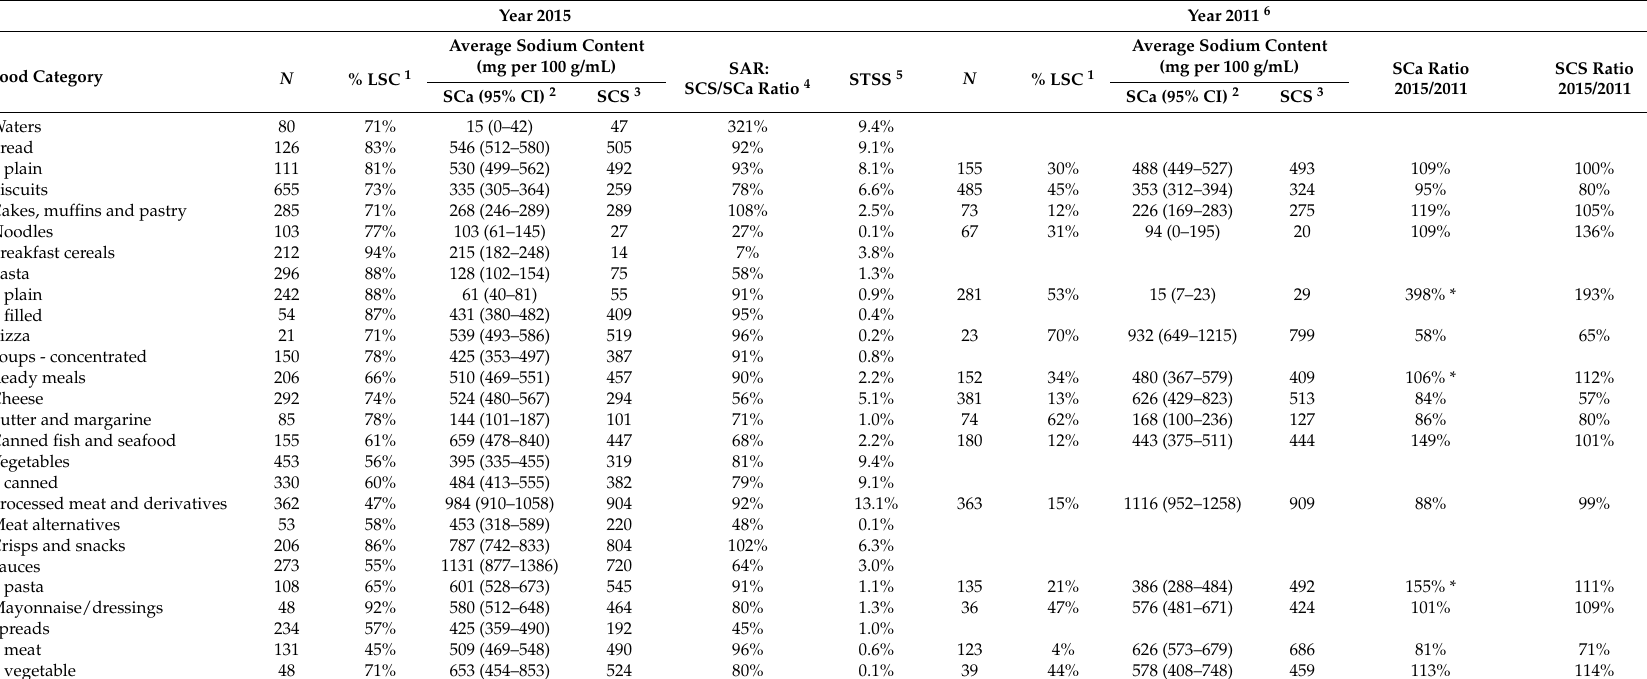
Table 1. Average sodium content of available (SCA) and sold (SCS) prepacked foods for selected food categories in 2011 and